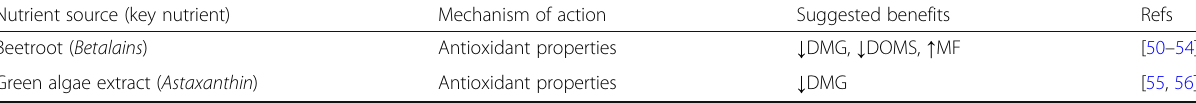
Table 2 Overview of vegetables and plant-derived supplements Nutrient source (key